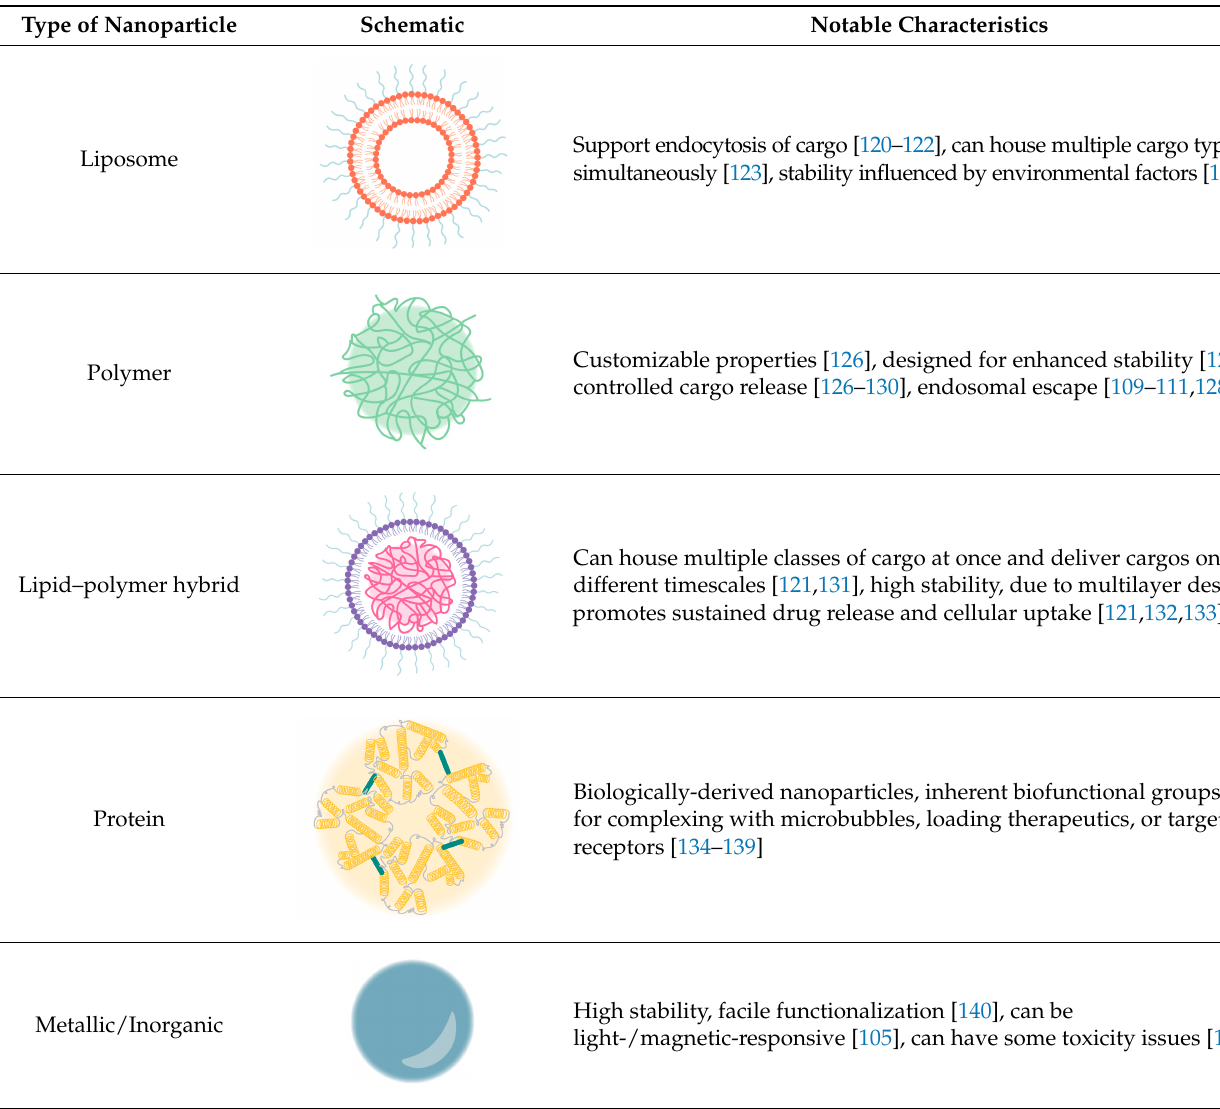
Table 1. Nanoparticles implemented in microbubble–nanoparticle complexes.